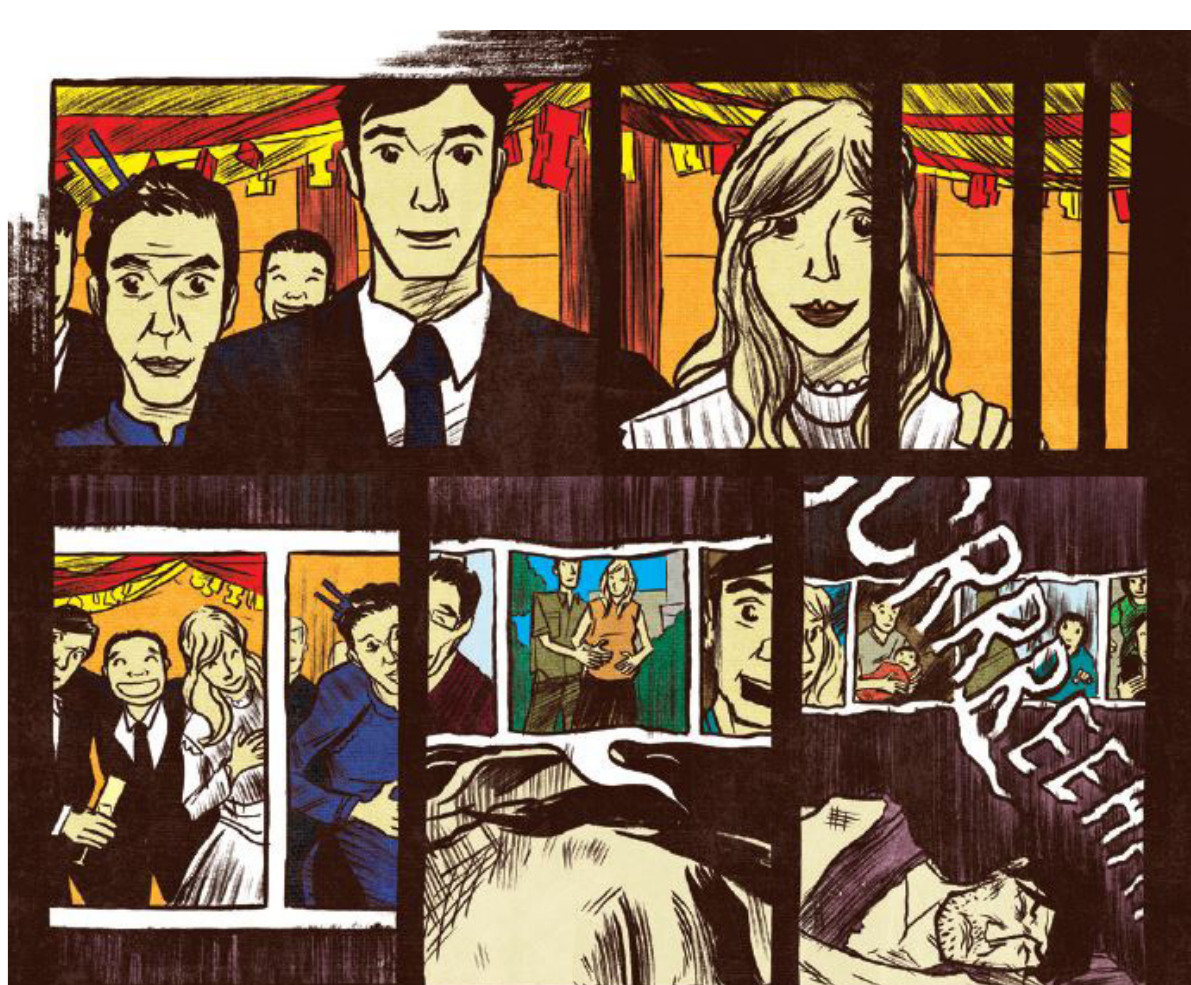
Figure 3: Tran, GB (2011) Vietnamerica (London: Villard,